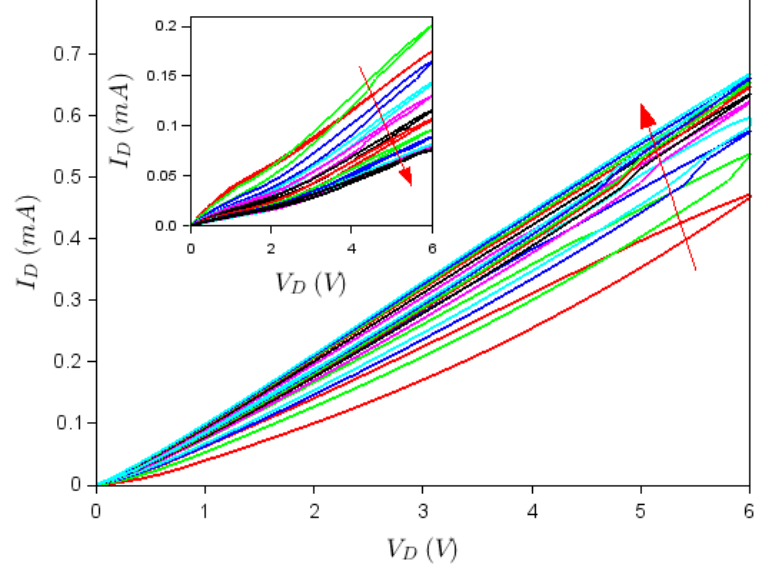
−= Figure 4. Dependence at V TG = − 2 V, V BG = 0, and di ff erent drain voltage sweeps. The arrow indicates V V, V = 0, and different drain voltage sweeps. The arrow Figure 4. Dependence at 2 TG BG the direction of increase of the sweep number. Inset: same dependence for V TG = 3 indicates the direction of increase of the sweep number. Inset: same dependence for